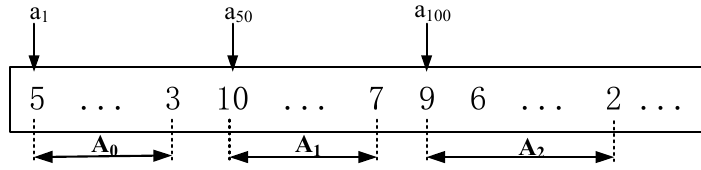
Figure 7. Schematic diagram of rolling-plan chromosome coding.